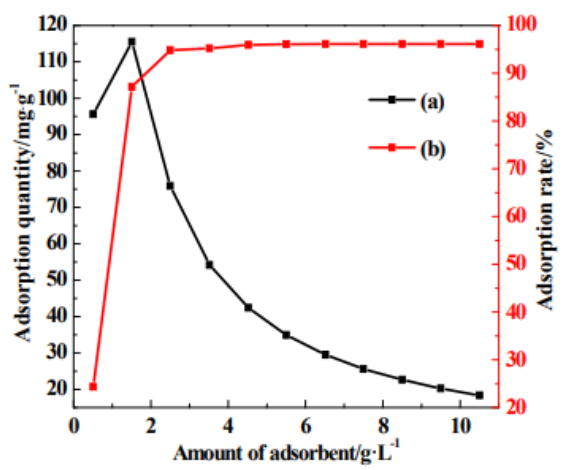
Figure 11. Effect of the amount of adsorbent on the adsorption performance of MDG.